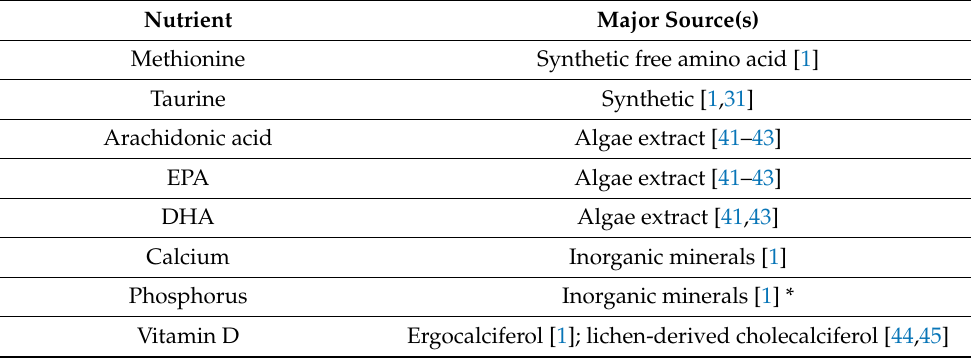
Table 6. Provision of key essential nutrients from non-animal